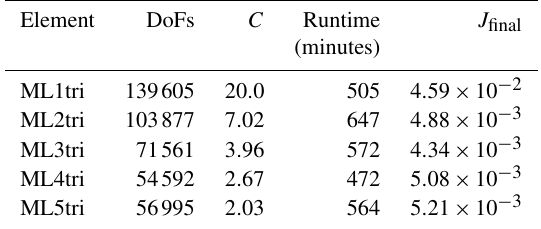
Table 3. The number of degrees of freedom (DoFs) for each exper- iment, the cells per wavelength C used to generate the mesh, the total wall-clock time to run each FWI discretized with a different element type, and the final cost functional J final . Element DoFs